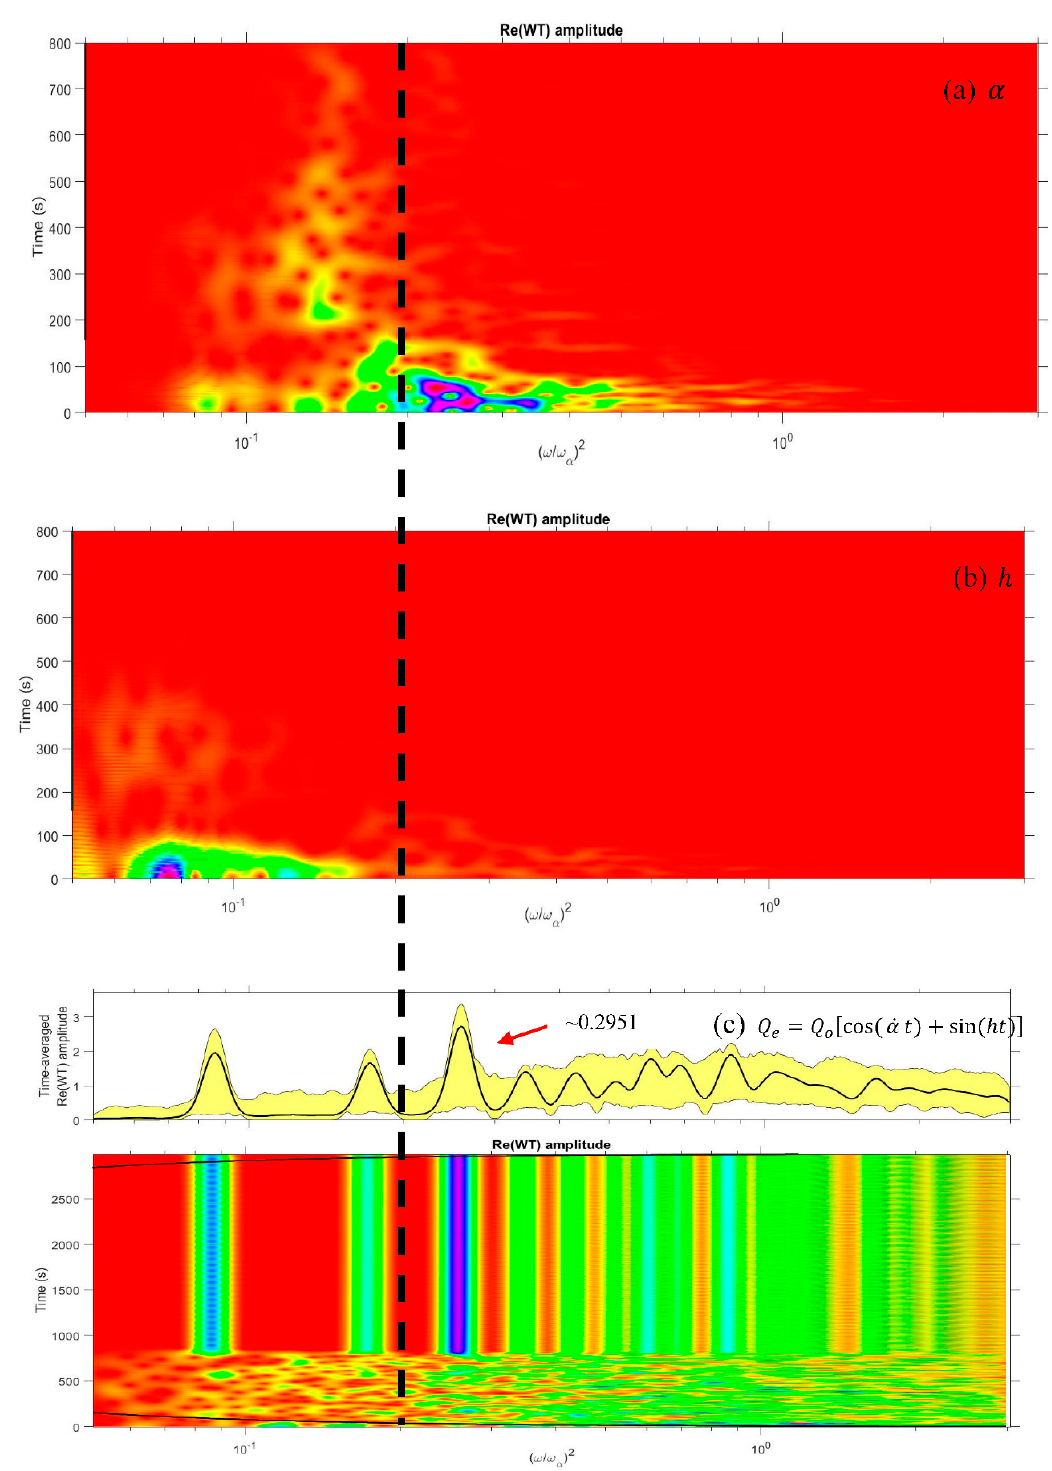
Figure 17. Overall e ff ect of control perturbation signal of system dynamics ( Q o = 15.6). ( a ) Time frequency analysis of the bending (h) dof. ( b ) Time frequency analysis of the pitch ( α ) dof. ( c ) Time frequency analysis of the prescribed perturbation signal. Note that the perturbation signal contains spectral components not present in the time frequency analyses of the aeroelastic displacements